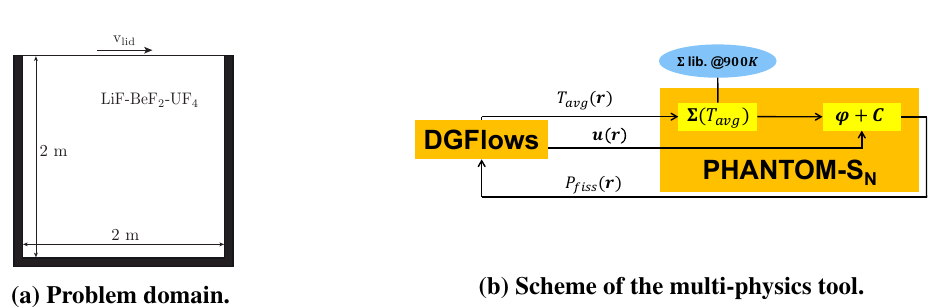
Figure 1: (a) square cavity domain of the simplified MSR system. (b) Computational scheme of the multi-physics tool used as reference model.